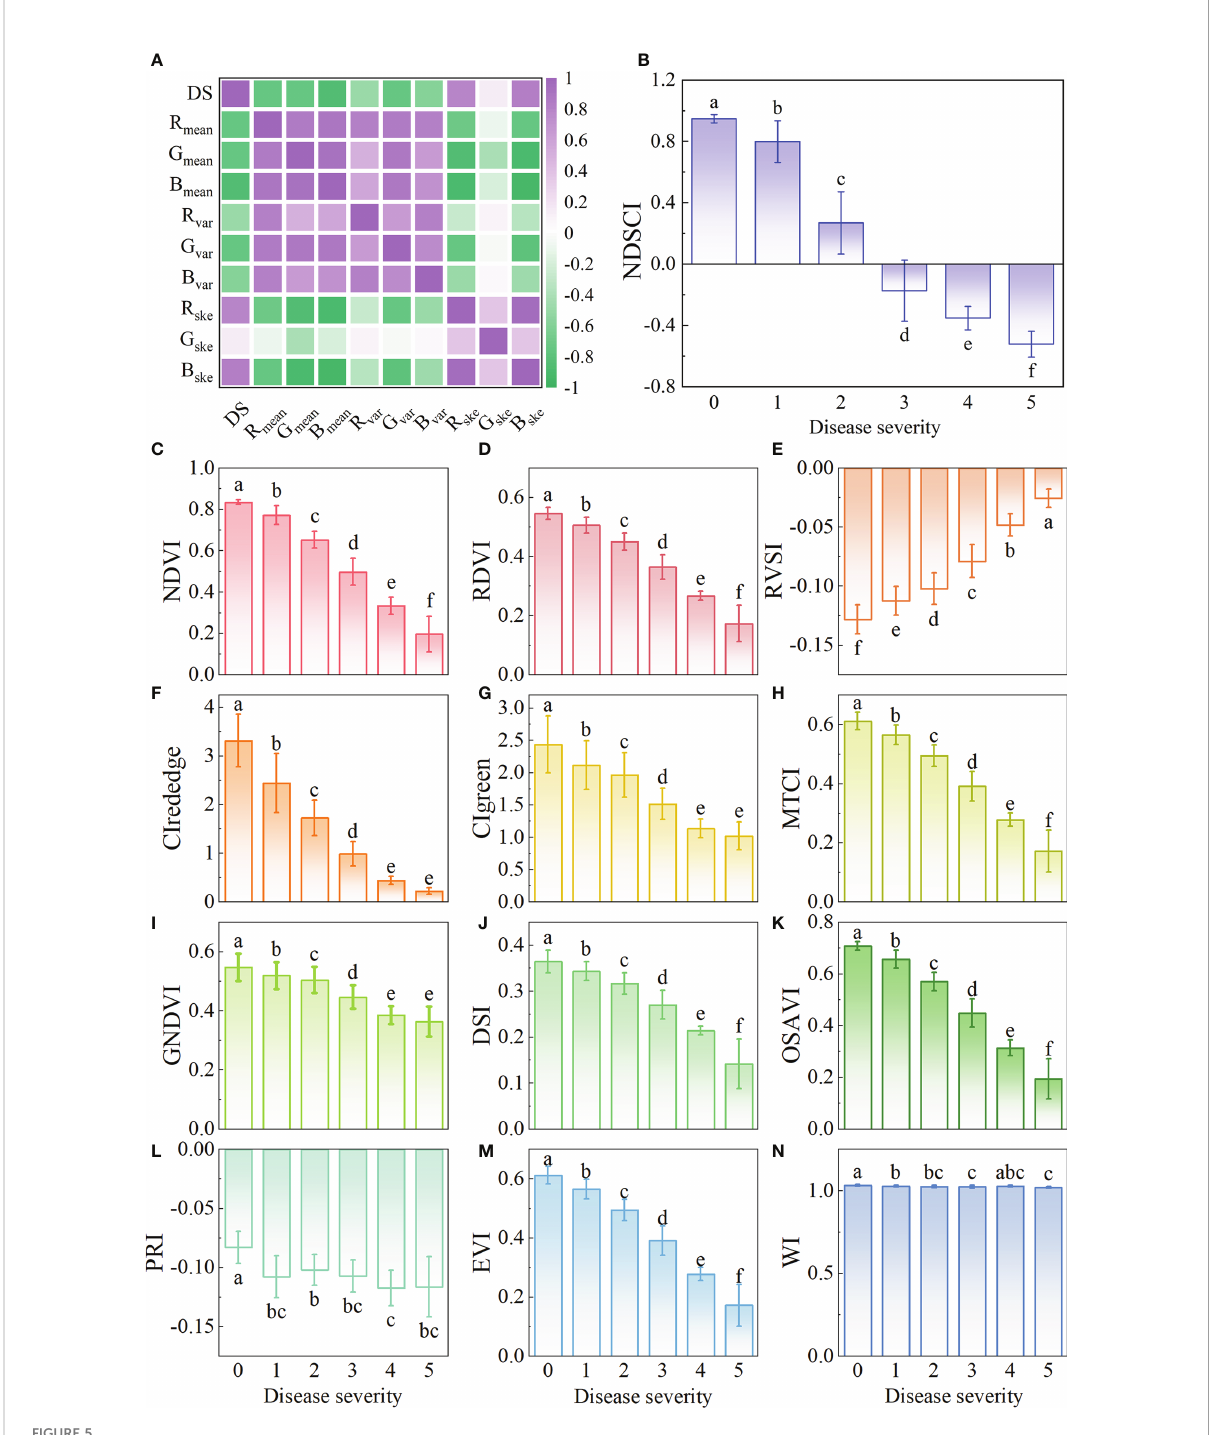
FIGURE 5 Results of the construction of new spectral index. (A) The correlation of the color features and disease severity. The variation of (B) NDSCI, (C) NDVI, (D) RDVI, (E) RVSI, (F) CI rededge , (G) CIgreen, (H) MTCI, (I) GNDVI, (G) DSI, (K) OSAVI, (L) PRI, (M) EVI, and (N) WI. Different letters indicate signi fi cant differences between different disease severity using the Tukey method (P<0.05). Black plots represent the lodging of rice in the plot, which are not considered in the